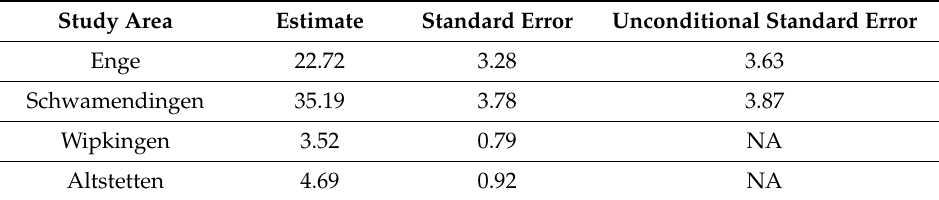
Table A2. Population size estimates for the study area plots resulting from the capture-mark-recapture (CMR) data (hedgehogs / 1 km 2 2